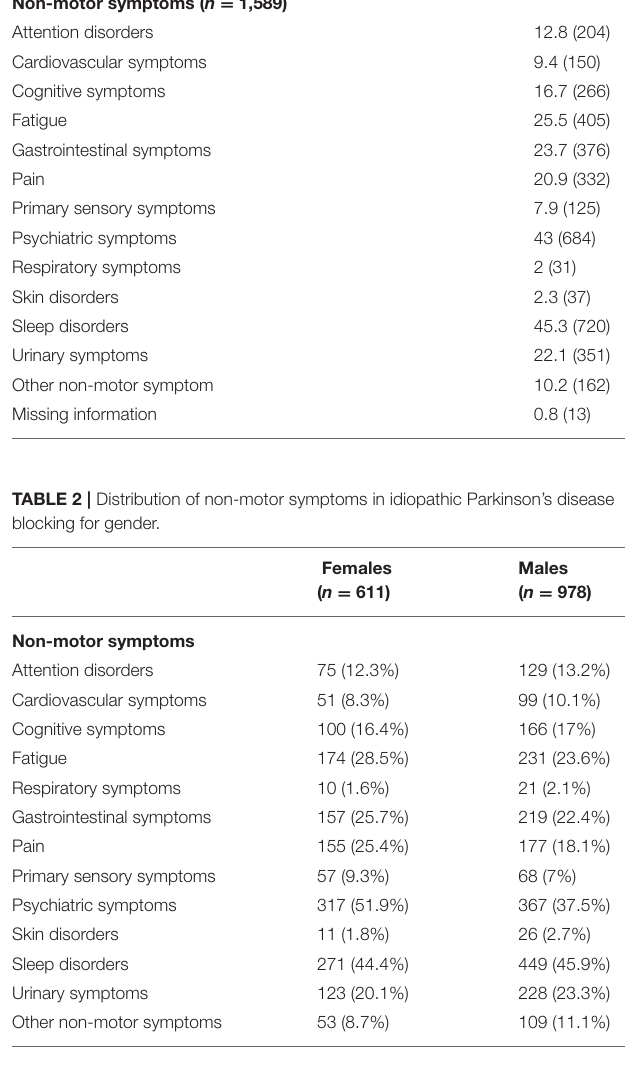
TABLE 1 | Distribution of non-motor symptoms in idiopathic Parkinson’s disease.